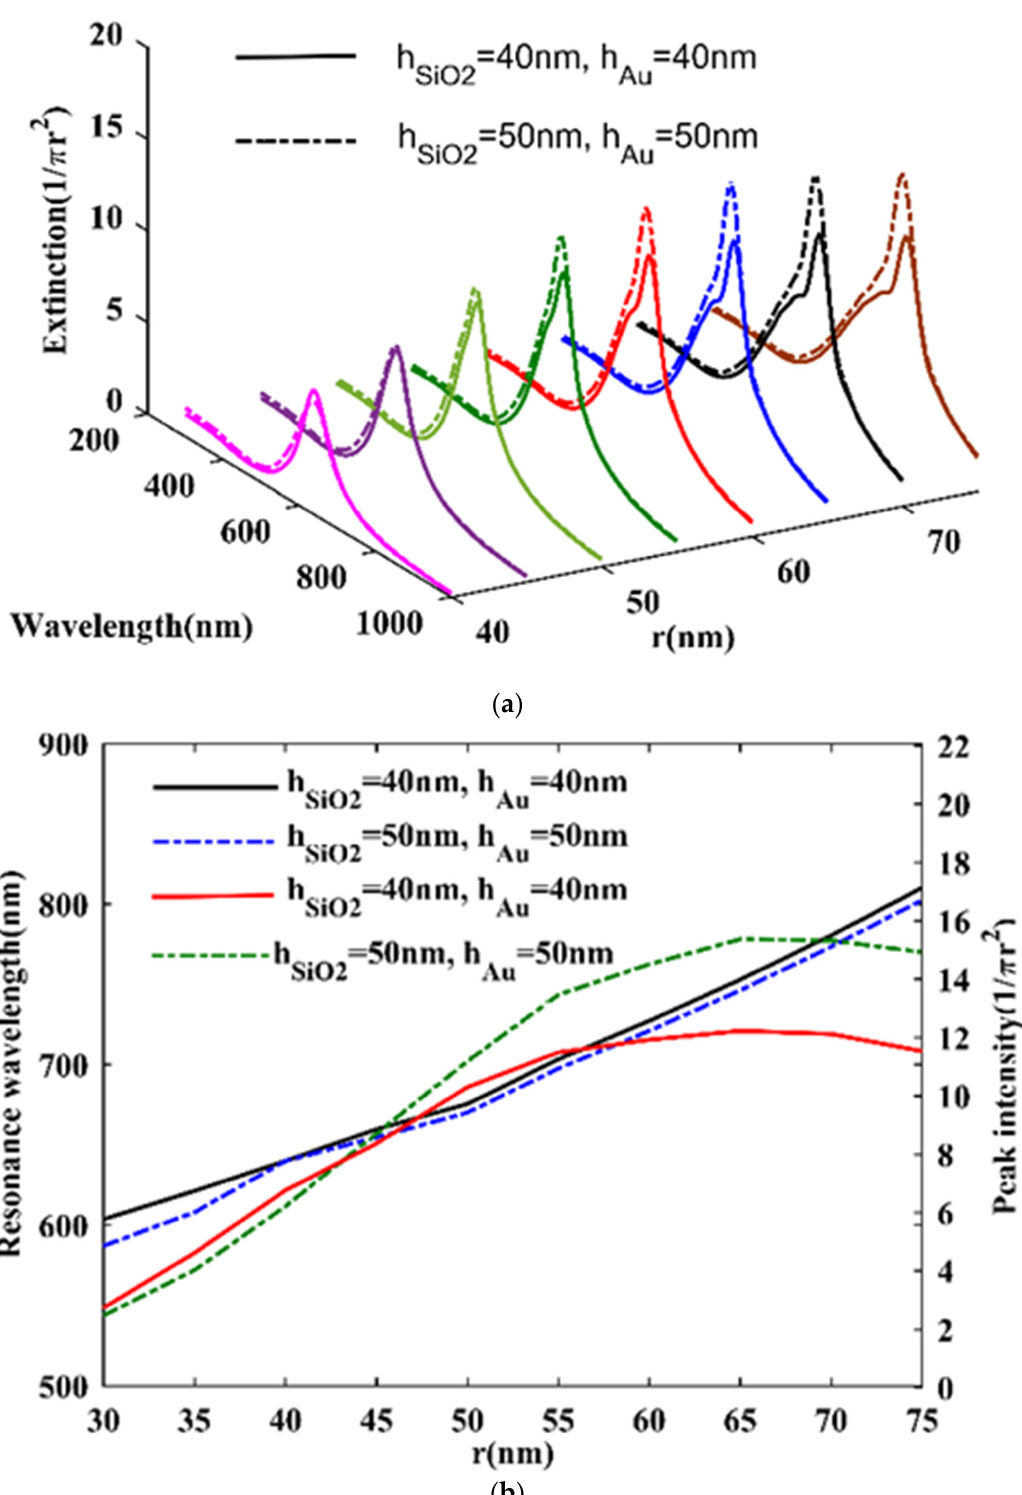
Figure 4. Extinction, resonance wavelength, and peak intensity of MIM nanocylinders: ( a ) 40 nm/40 nm/40 nm and ( b ) 50 nm/50 nm/50 nm Au/SiO 2 /Au thicknesses.